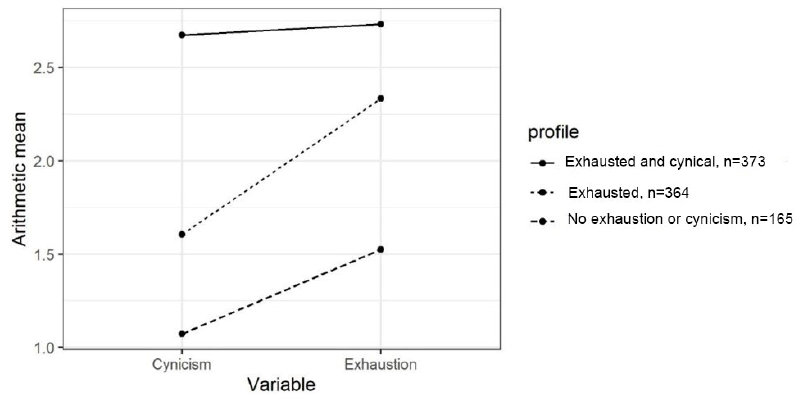
Figure 1. The group means for the indicator variables for study-related burnout profiles. Table 2. Study credits and GPAs (grade point averages) across profiles.